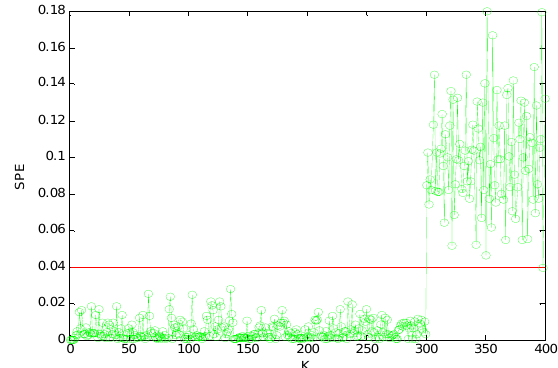
Figure 6. SPE value with sensors 1, 3